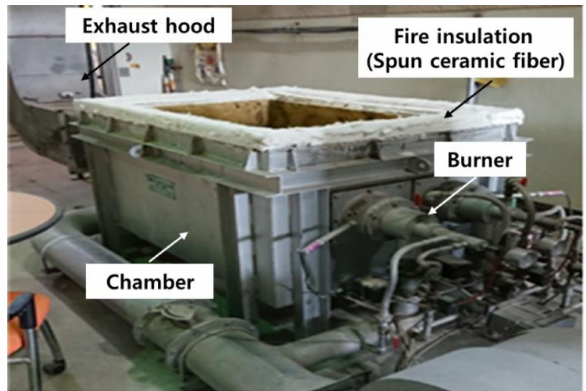
Figure 4. Horizontal heating furnace for the high-temperature test.